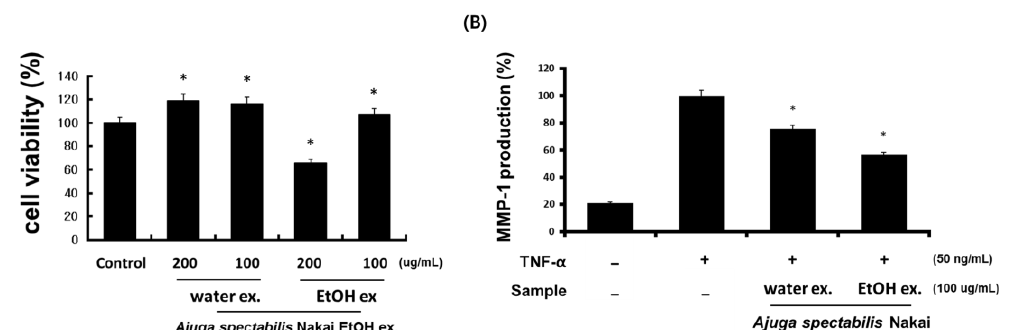
Figure 3. Effect of AS-W, AS-E on cell viability ( A ) and MMP-1 inhibition ( B ) in CCD-986sk fibroblasts. The cells were treated with various concentration of AS-W, AS-E for 48 h. * p < 0.05 compared with control.